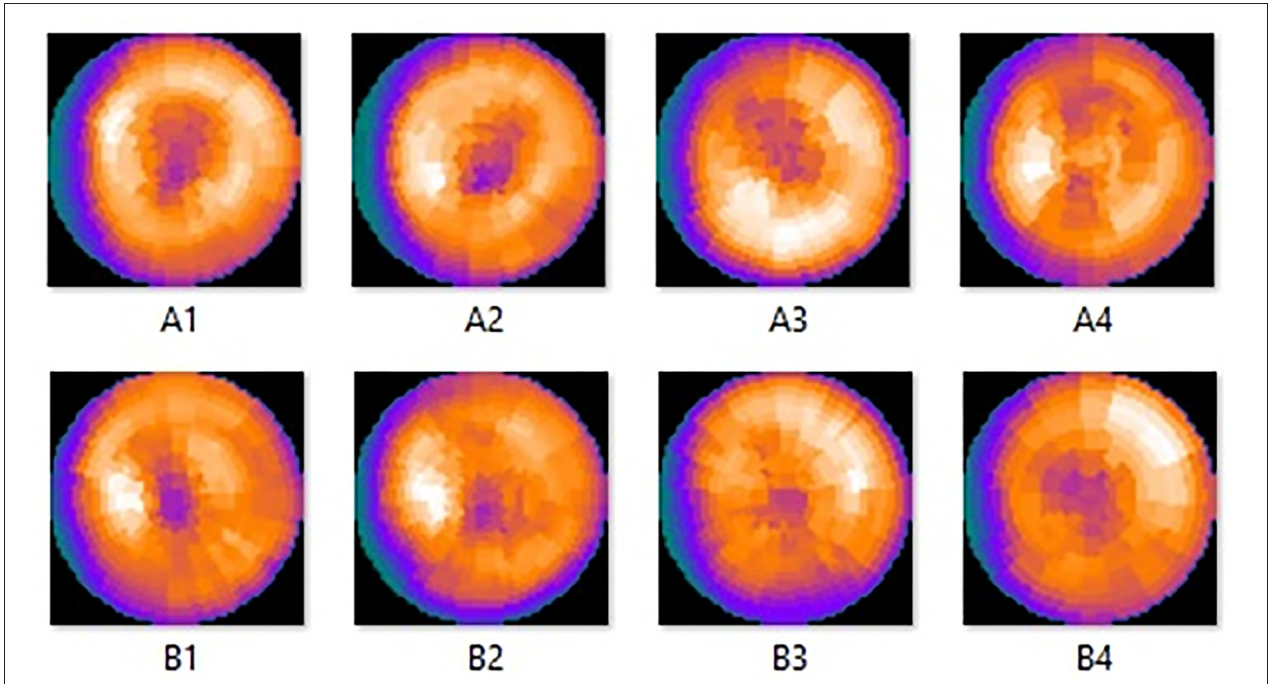
FIGURE 1 | Examples of female polar maps (A1, A2, A3 and A4) and male polar maps (B1, B2, B3 and B4).